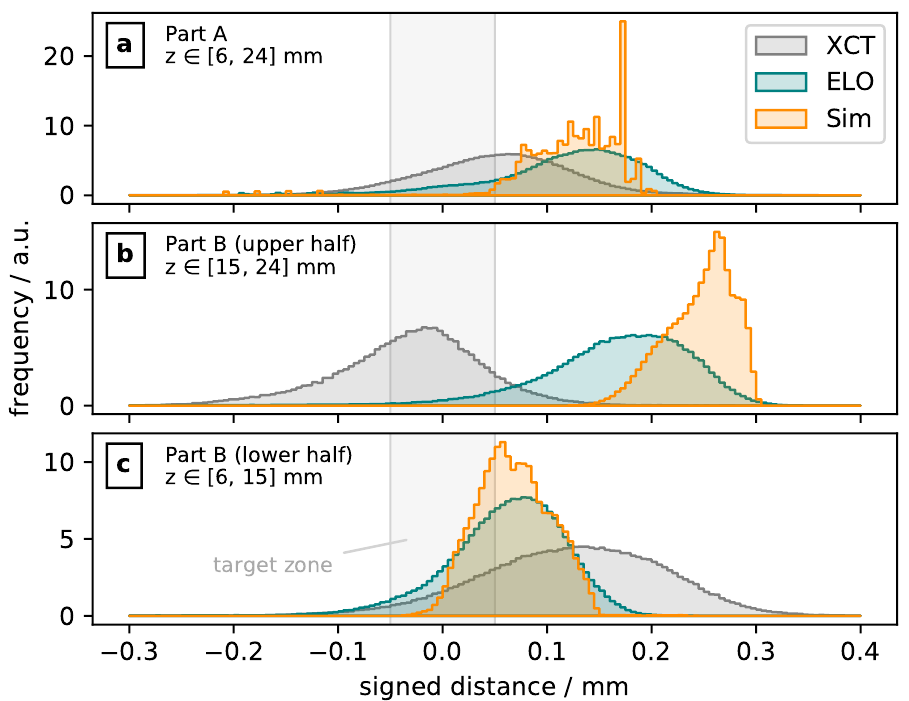
Figure 3. Signed distance histograms of ( a ) part A, ( b ) upper section of part B and ( c ) lower section of part B for XCT, ELO and simulation